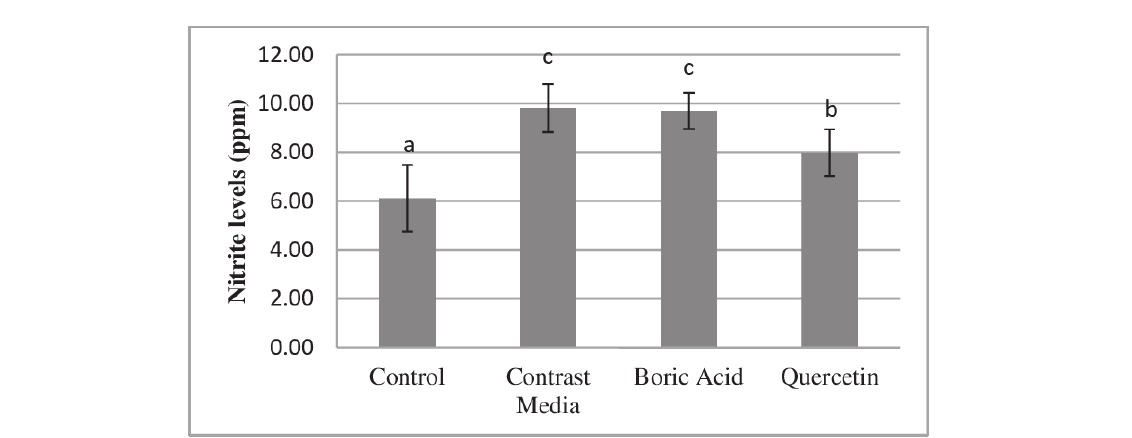
FIGURE 3 - Changes in serum nitrite levels among the groups in our study. Statistically insignificant differences are indicated by identical letters, and statistically significant differences are indicated by different letters. P <0.05 was considered statistically significant.